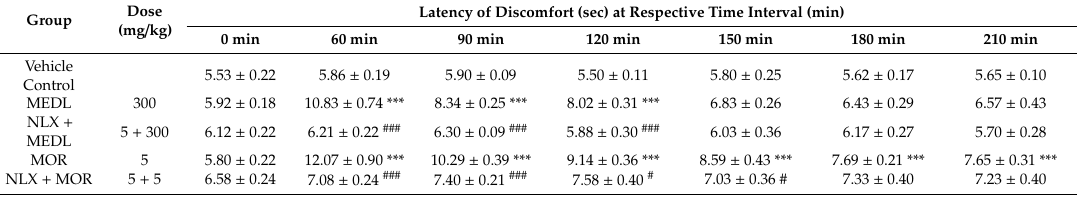
Table 2. E ff ects of naloxone on MEDL–induced antinociception in the hot plate test in mice. Group Dose (mg /